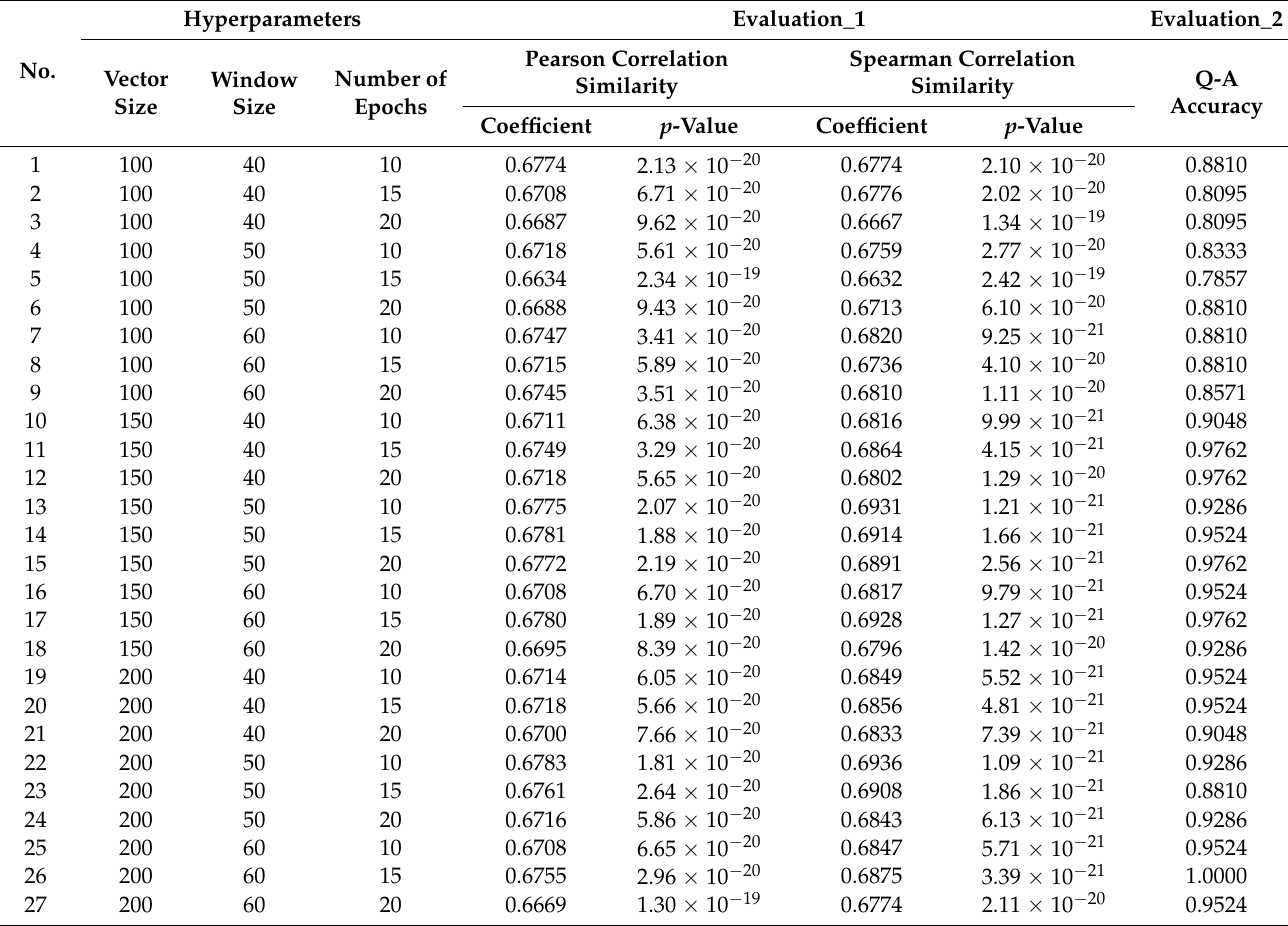
Table 1. Word-embedding model evaluation results based on hyperparameter